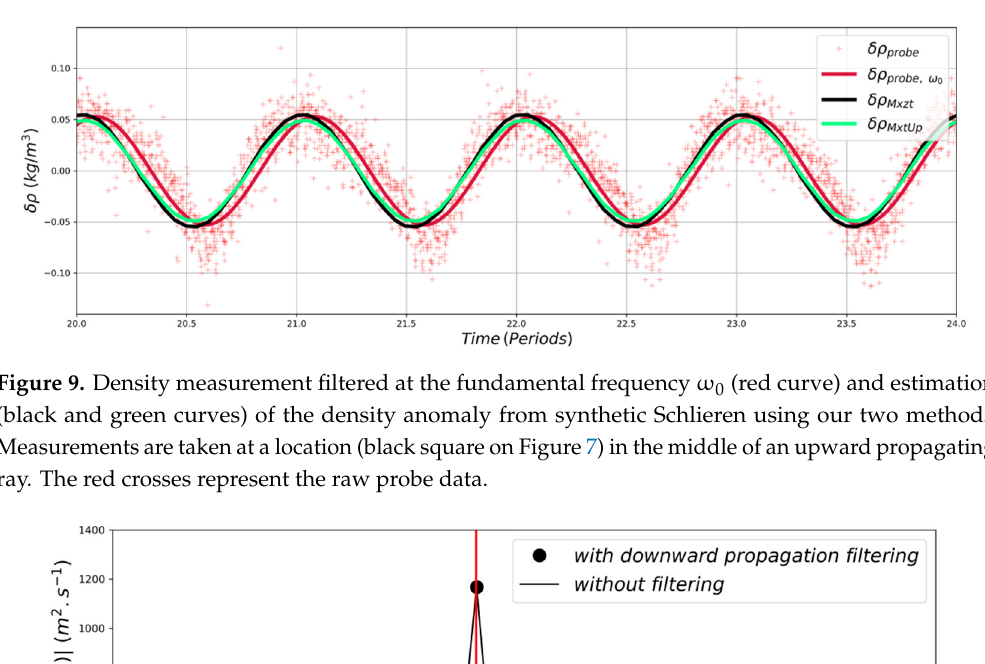
Figure 9. Density measurement filtered at the fundamental frequency ω 0 (red curve) and estimation (black and green curves) of the density anomaly from synthetic Schlieren using our two methods. Measurements are taken at a location (black square on Error! Reference source not found. ) in the middle of an upward propagating ray. The red crosses represent the raw probe data.